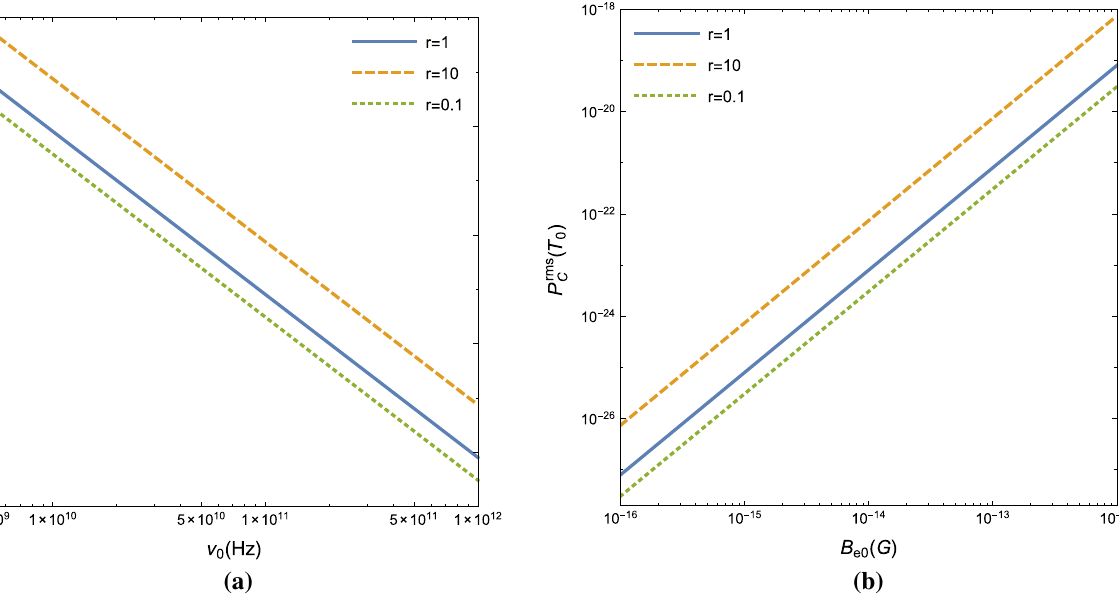
( T ) as a function of the magnetic field amplitude B ization P rms 0 C value of the CMB frequency ν 0 = 10 9 Hz and | r | = 0 . 1 , 1 , 10 (where 0 r ≡ U i / Q i ) are shown. In both plots we used a value of | Q i | = 10 −